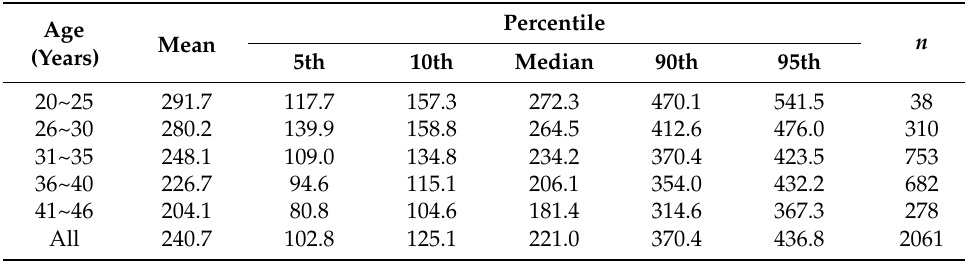
Table 4. Serum DHEA-S level distribution ( µ g/dL) according to